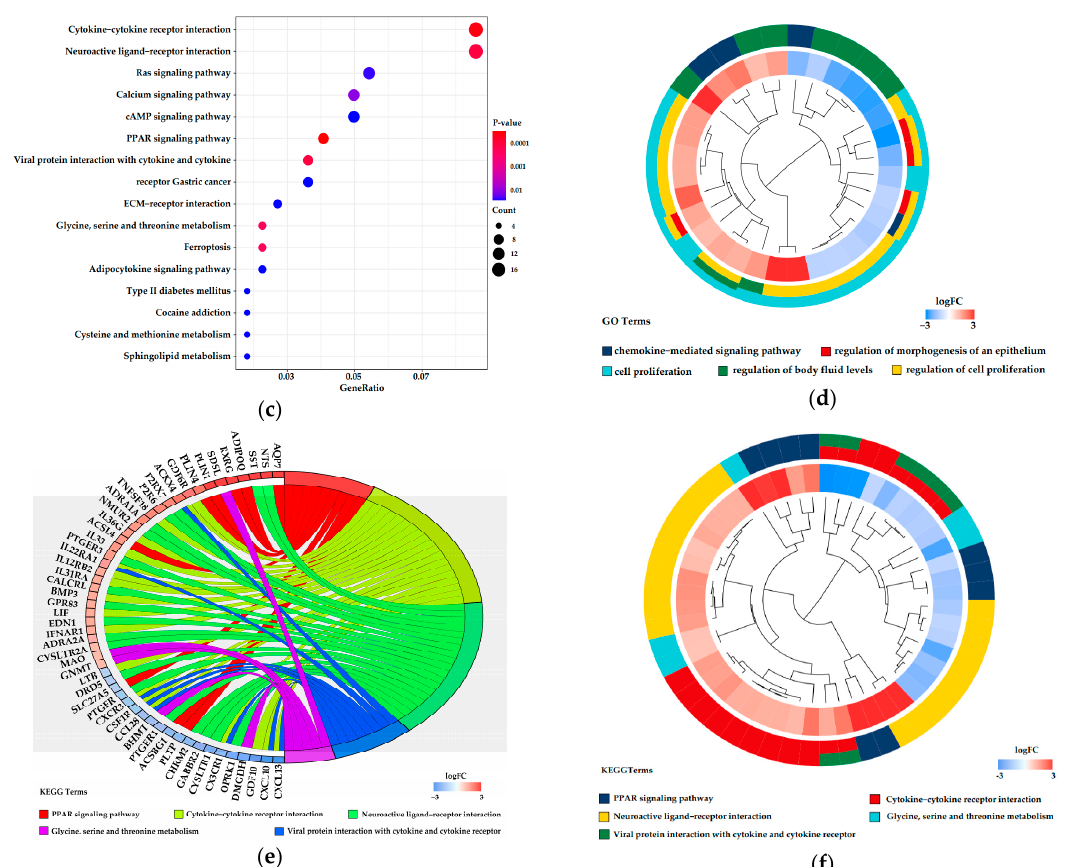
Figure 3. Gene ontology (GO) enrichment and Kyoto Encyclopedia of Genes and Genomes (KEGG) pathway analysis of DEGs. ( a ) Top 10 significant terms in each category were listed. ( b ) Circos plots showing overlapping and specific response of DEG-enriched top 5 significant GO terms. ( c ) Circos plot summarizing selected features of DEG-enriched in top 5 significant GO terms. ( d ) Scatter plot of significantly-enriched KEGG pathways of DEGs. ( e ) Circos plots showing overlapping and specific response of DEGs enriched in significant key KEGG pathways. ( f ) Circos plot summarizing selected features of DEGs enriched in key KEGG pathways.